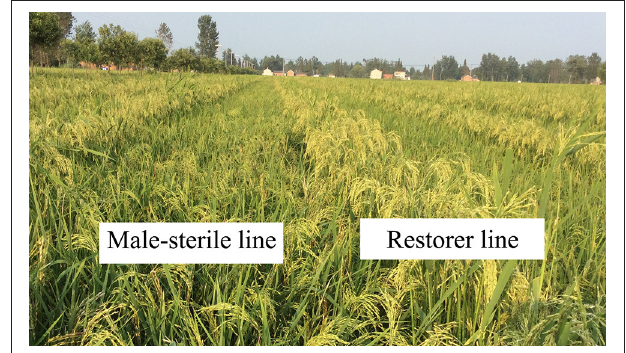
FIGURE 1 | Scene of F 1 hybrid seed production in the filling stage.